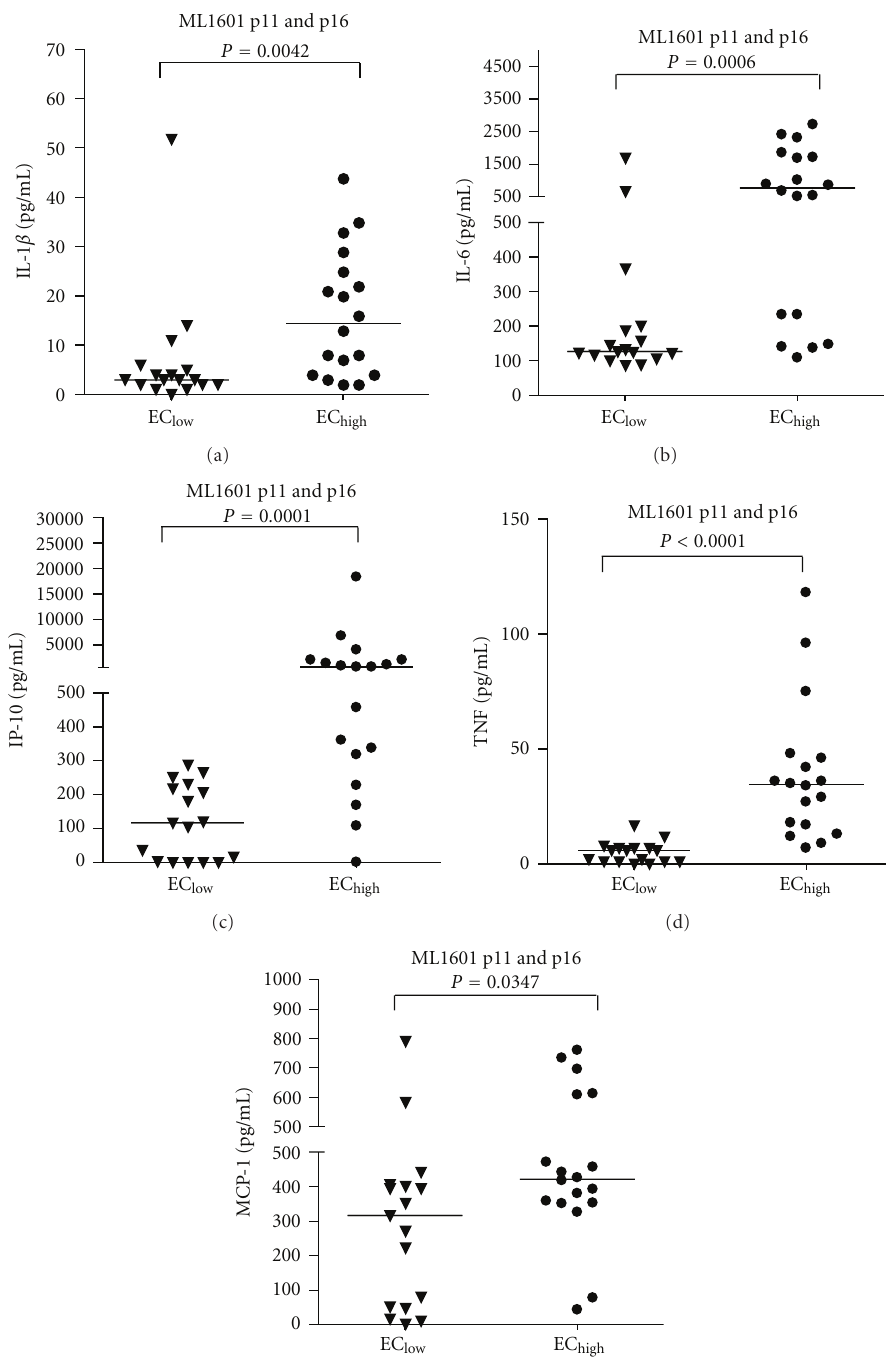
Figure 5: Production of IL-1 β (a), IL-6 (b), IP-10 (c), TNF- α (d), and MCP-1 (e) in response to selected ML1601c peptides measured after 24h culture of undiluted whole blood derived from 34 Ethiopian healthy controls (ECs) derived from areas with low endemicity for leprosy (EC low : n = 16) or from areas highly endemic for leprosy (EC high : n = 18). peptides can be used to identify M. leprae exposure in gen- etically di ff erent